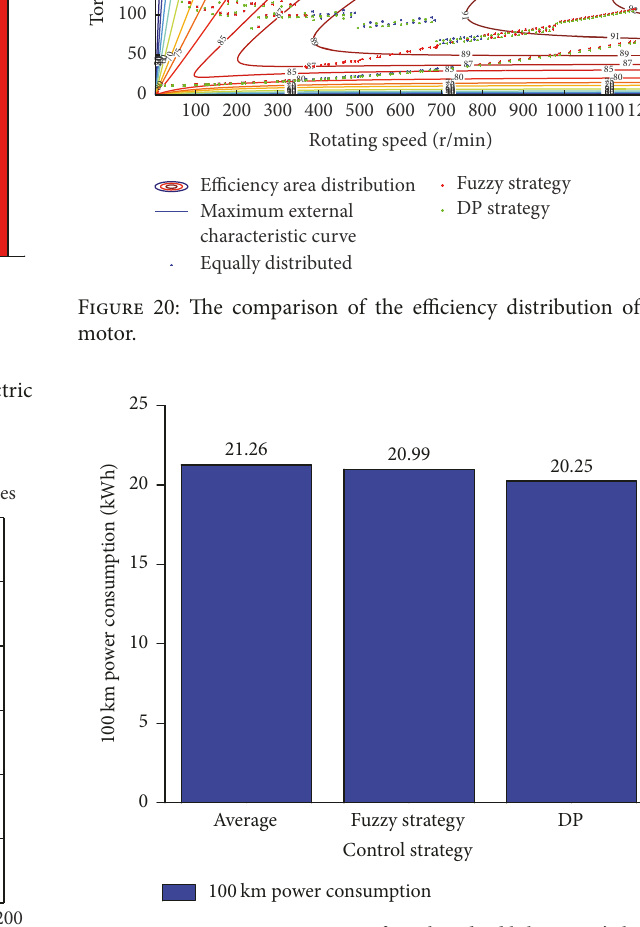
Figure 21: Energy consumption of one hundred kilometers’ electric drive